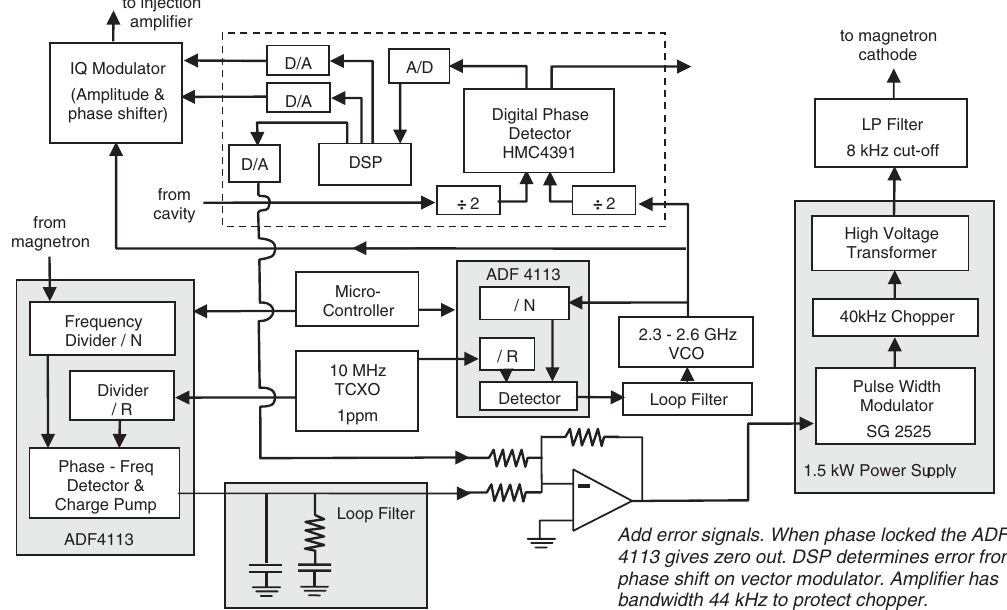
FIG. 12. Active control arrangement with magnetron in a phase lock